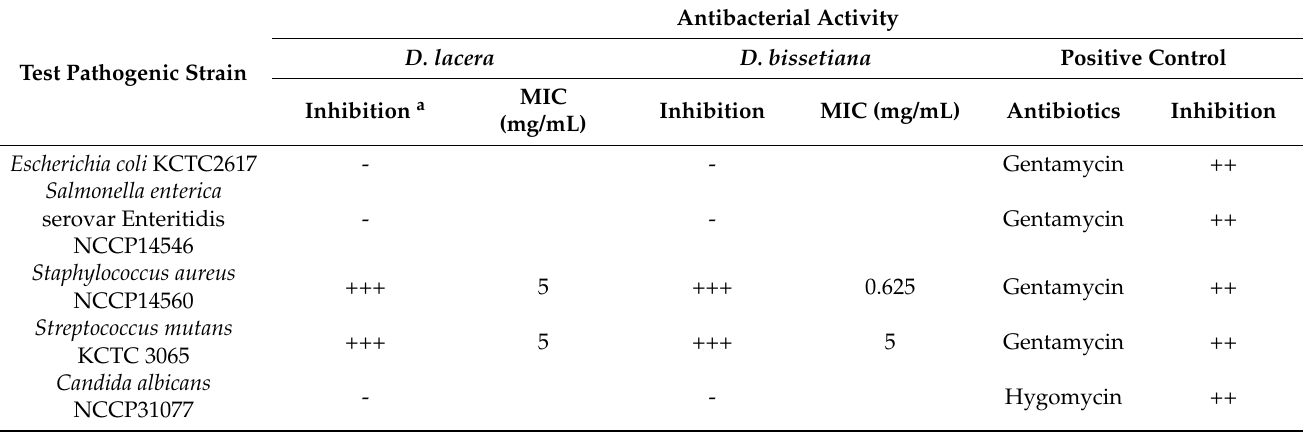
Table 3. Antibacterial activity of the plant extract against the indicator